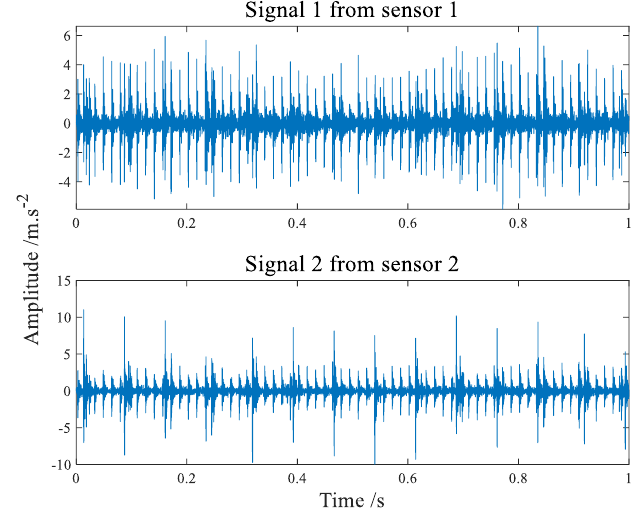
Figure 12. The time − domain waveform of composite fault signals.